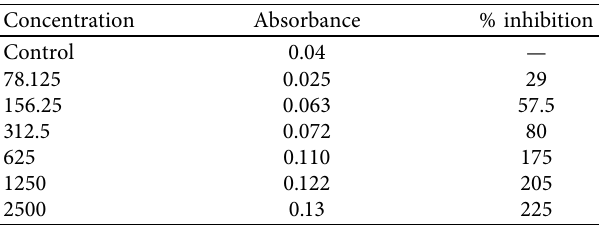
Table 9: Absorbance of standard (diclofenac sodium).